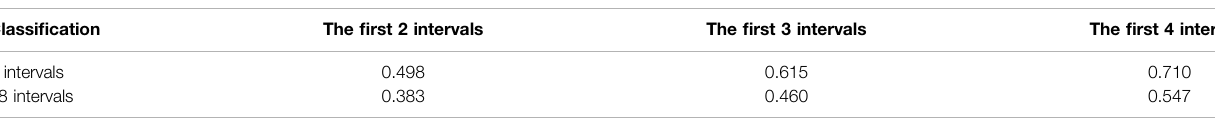
TABLE 3 | Proportion of the number of lines in different